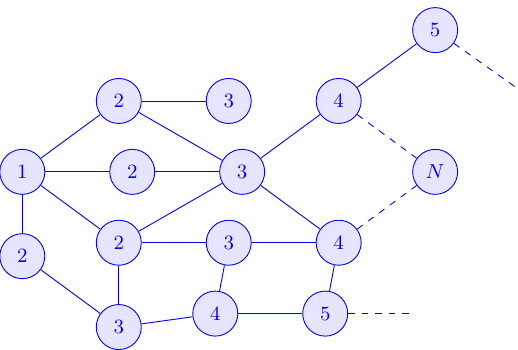
Figure 2: A schematic network of microstates, labelled by their numbers of centers, with many different tunneling transitions between states